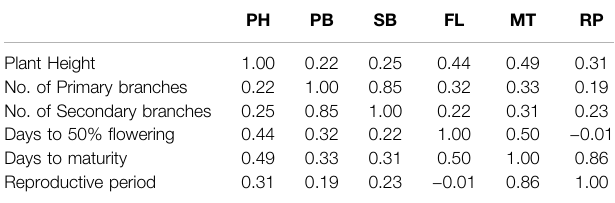
TABLE 3 | Pearson correlation coef fi cients among traits evaluated in the RIL